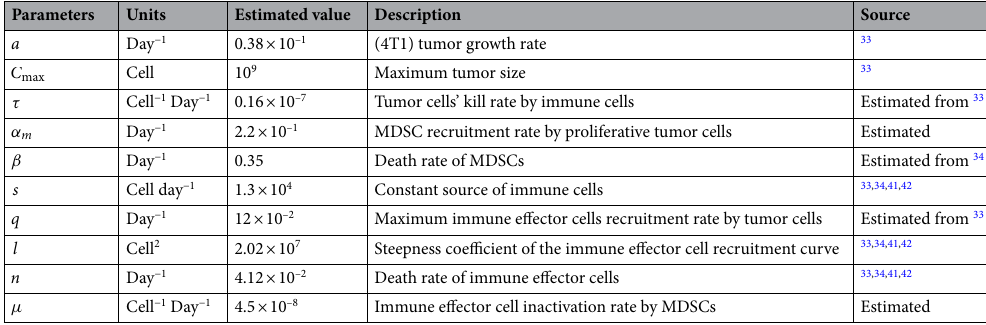
Table 1. Parameter